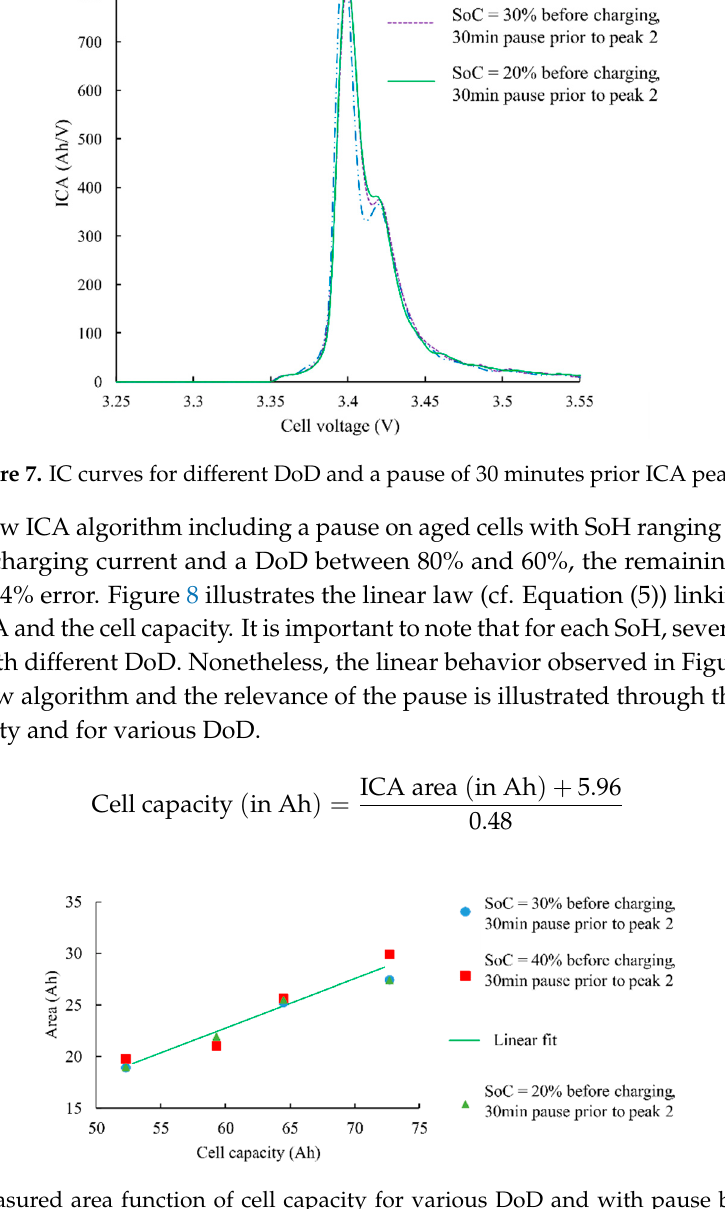
Figure 8. Measured area function of cell capacity for various DoD and with pause before peak 2 (C/3-25 °C).